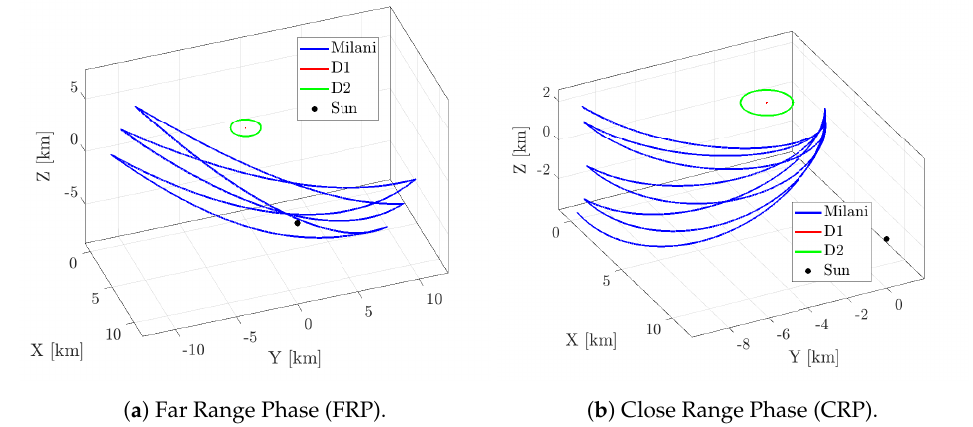
Figure 20. The trajectories for the two Milani’s mission phases (revisited from Pugliatti et al. [41]).